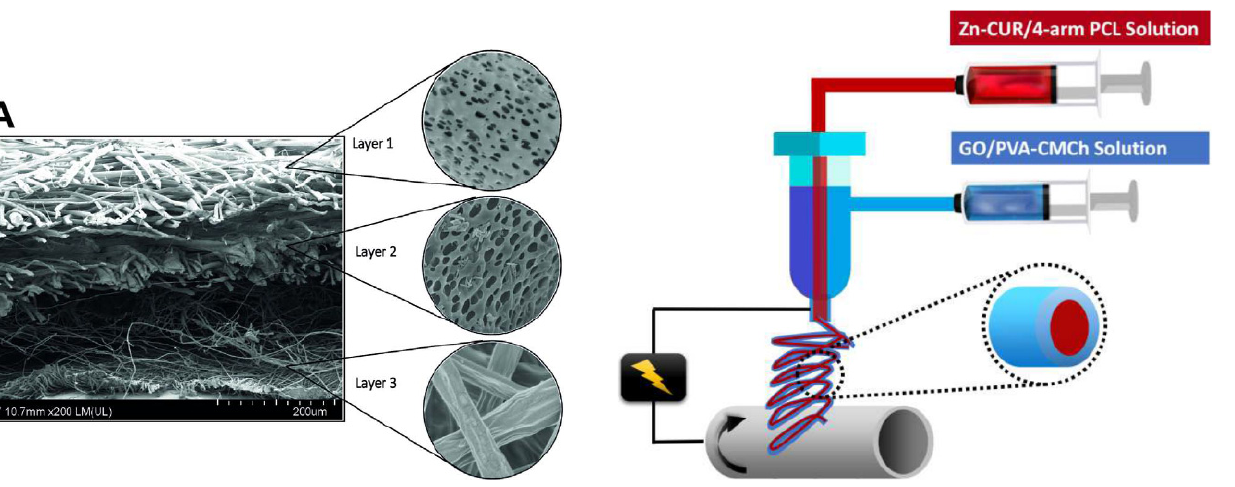
Fig. 5. FESEM micrograph of multilayered polylactic acid (PLA)/halloysite (HAL) porous nano¯brous membrane.